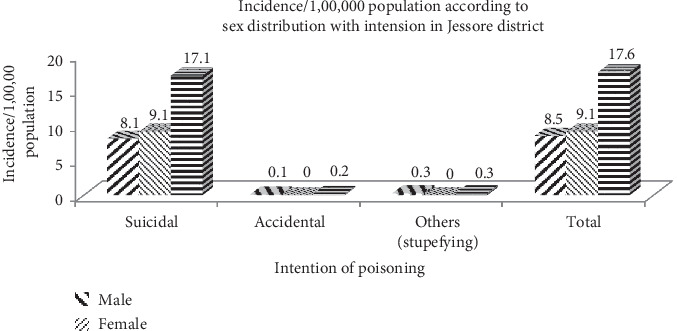
Incidence per 100,000 population according to age and sex distribution in Jashore district (Report of Department of Medicine, Jashore Medical College, Jashore) in a 6-month period. Total population of Jashore is 2764547, according to the 2011 census, Jashore district.